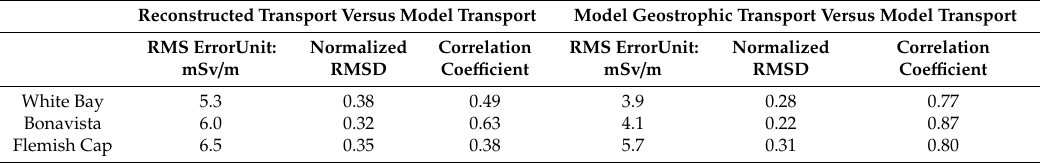
Table 2. Statistics comparing the reconstructed surface unit-depth transport and the model geostrophic surface unit-depth transport against the model surface unit-depth transport at the White Bay, Bonavista, and Flemish Cap transects. Locations are shown in Figure